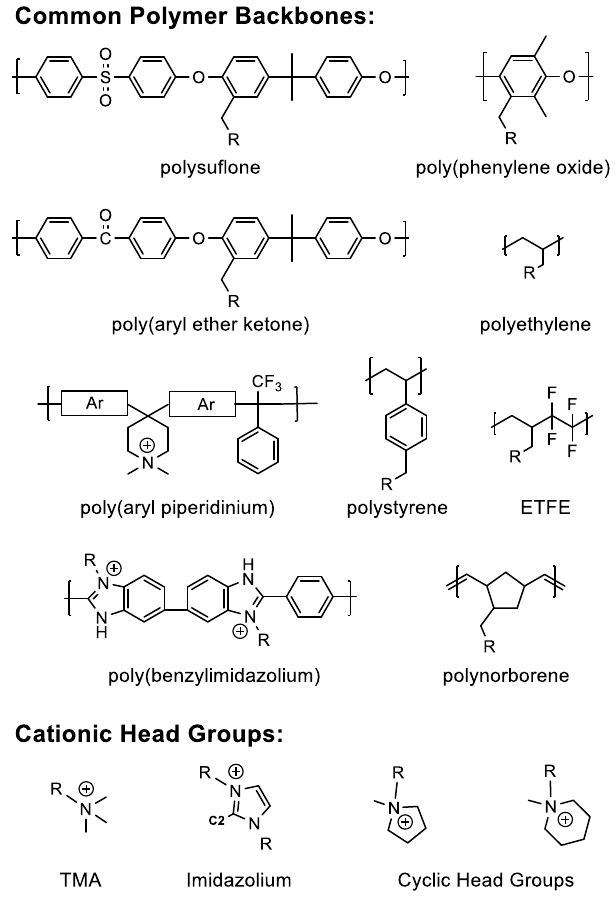
Figure 7. Common polymer backbones used in the synthesis of AAEMs as well as implemented cationic head groups. Abbreviations: TMA, trimethylammonium; ETFE, ethylene tetrafluoroethylene.